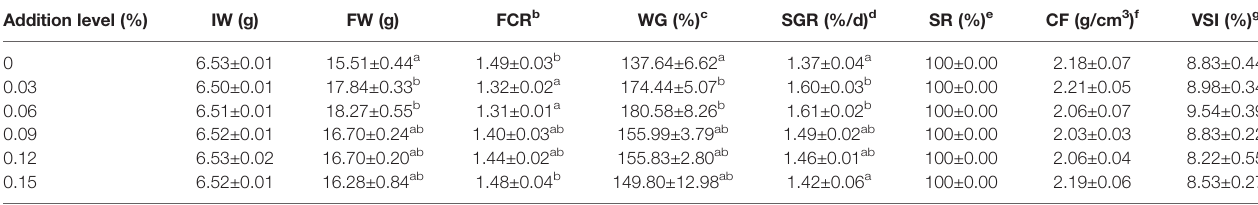
TABLE 4 | Effect of TB supplementation on growth performance and physical indexes of juvenile blunt snout bream a . Addition level (%)